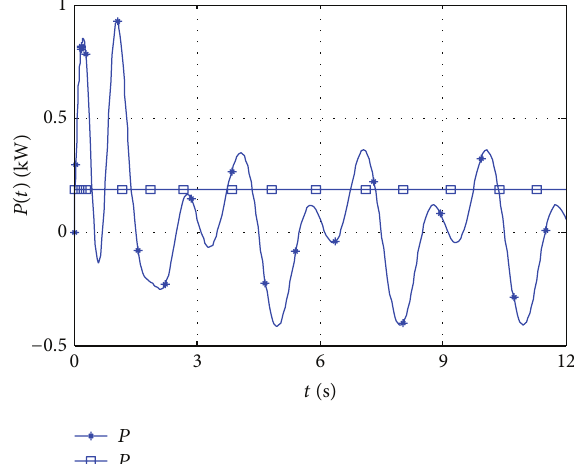
Figure 10: Tensegrity-based harvester: power for